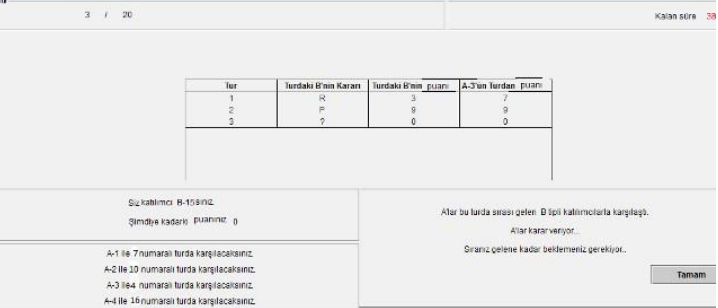
Figure A3. Waiting Type B’s Screen